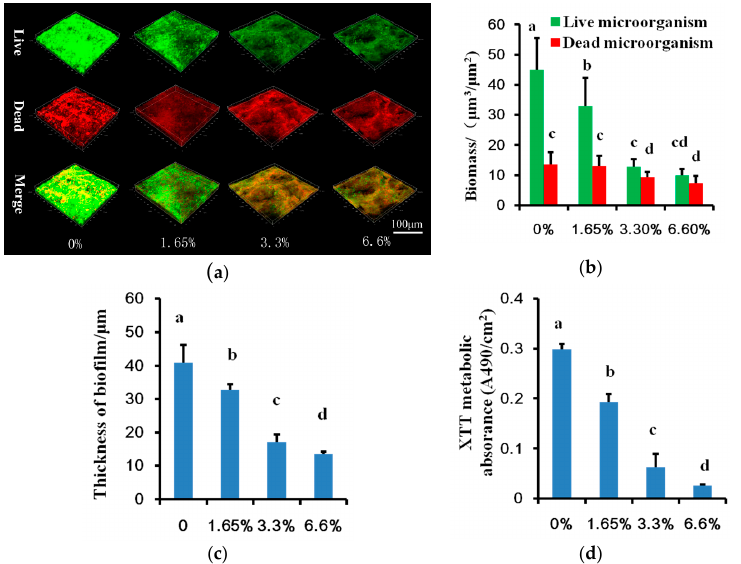
Figure 1. Colony forming unit (CFU) counts of multi-species biofilms: ( a ) The total CFU counts of 72 h multi-species biofilms in different dimethylaminododecyl methacrylate (DMADDM) containing groups; ( b ) The C. albicans CFU counts of 72 h multi-species biofilms in different group. Values are significantly different when labelled with different letters ( p < 0.05).